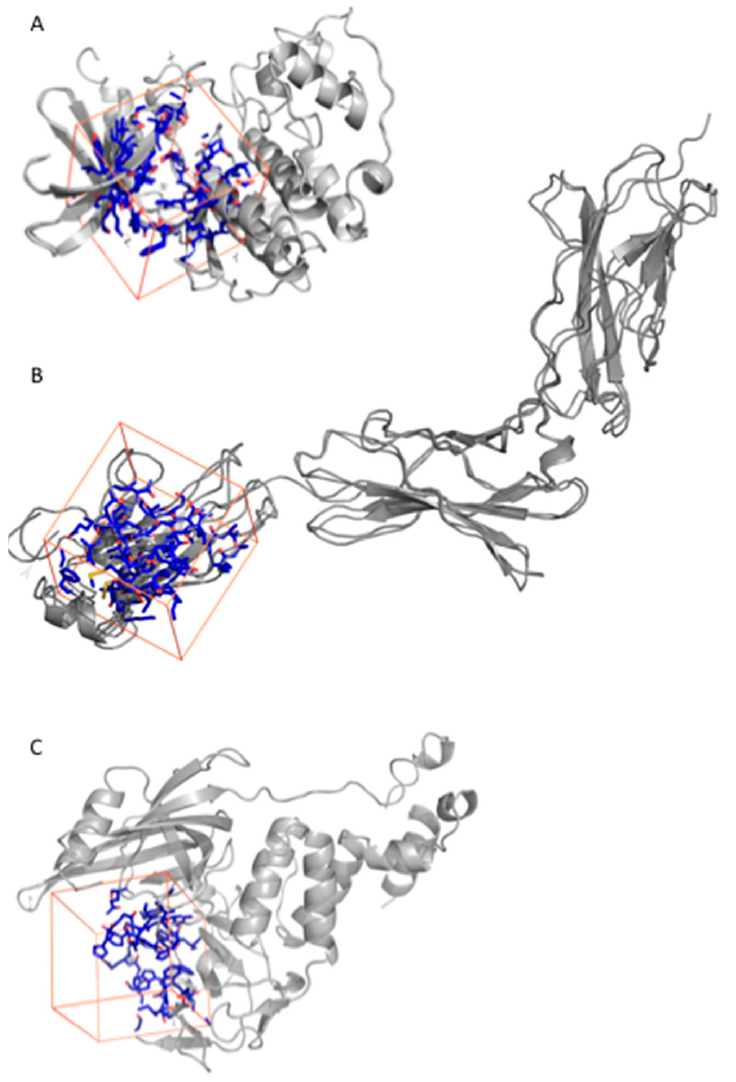
Figure 2. Visual representation of the AutoDock Vina box search space (in orange) for ( A ) CDK2 (Protein Data Bank (PDB) IDs: 1PXI and 1VYZ), ( B ) GP130 (PDB IDs: 1P9M and 3L5H), and ( C ) cereblon (PDB ID: 4CI1). All structures used for this study are superimposed and represented in gray cartoon; the residues of the binding sites are represented in blue sticks. Table 1. MTiOpenScreen and AMMOS2 screening for three proteins.